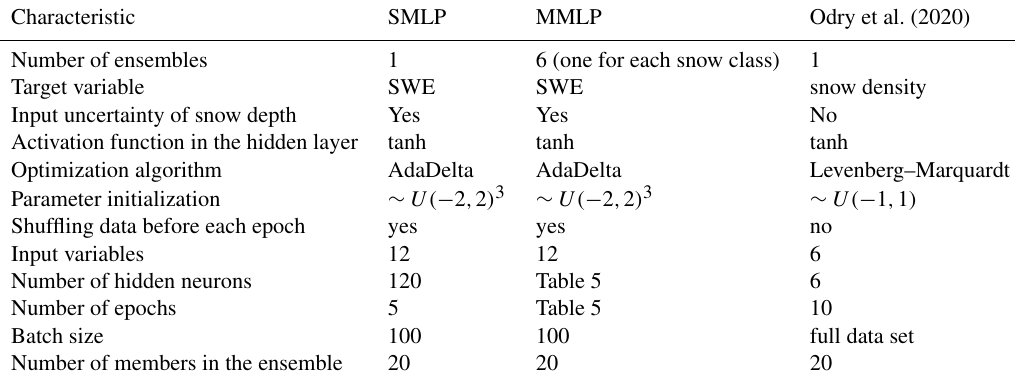
Table 6. Final setup of the MLPs for the single MLP ensemble model (SMLP) and the multiple MLP ensemble model (MMLP); the ensembles in the MMLP model differ only in terms of their number of hidden neurons and number of epochs. As a comparison, the setup of the ANN ensemble proposed by Odry et al. (2020) is presented as well.